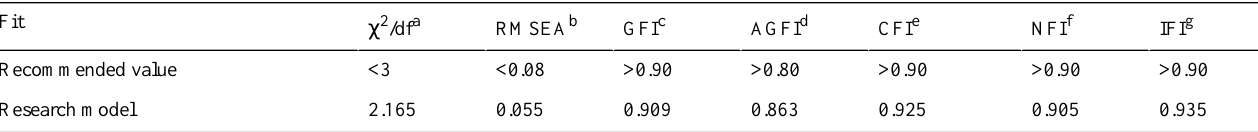
Table 4. Fit index of the research